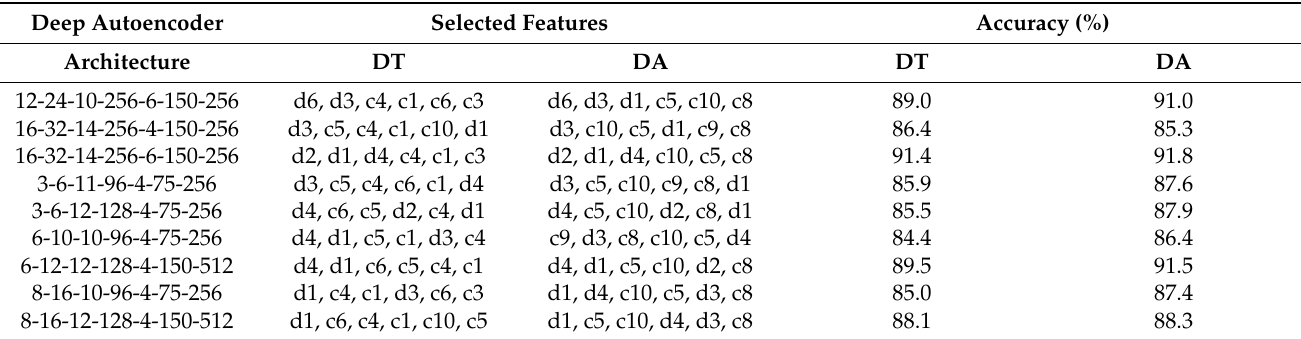
Table 3. Selected combined standard and deep features in order of importance and corresponding classification accuracy for DT and DA